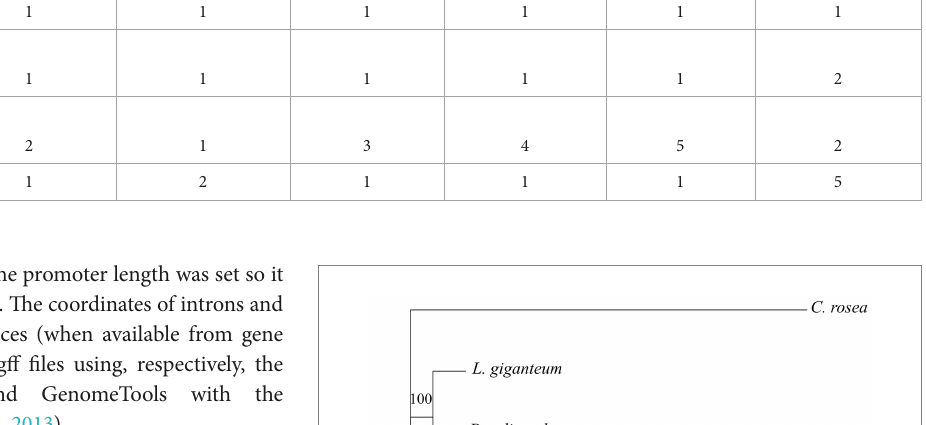
TABLE 1 Copy number of genes coding for DCLs, AGOs and RDRPs in the species considered in this study. Enzyme class